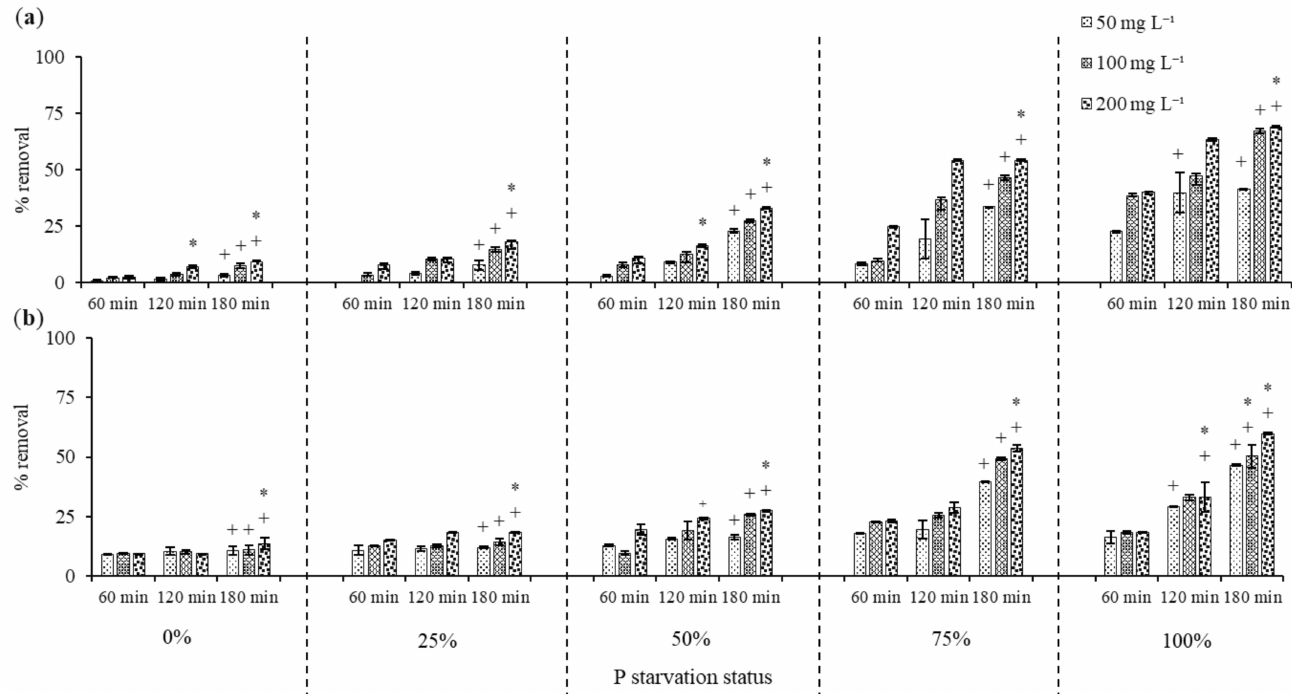
Figure 1. Percent removal of phenol by C. vulgaris dried biomass starved with 0, 25, 50, 75, and 100% phosphorus at ( a ) 100 mg L − 1 and ( b ) 200 mg L − 1 phenol exposure. In all cases, p < 0.05, and n = 3 ± SE. + on bars, within each phosphorus starvation status (0, 25, 50, 75, or 100%), represents the significantly highest phenol removal at the specific time of exposure (60, 120, or 180 min) with the same concentration of biomass (50, 100, or 200 mg L − 1 ), while * on the bar represents significantly highest phenol removal within all